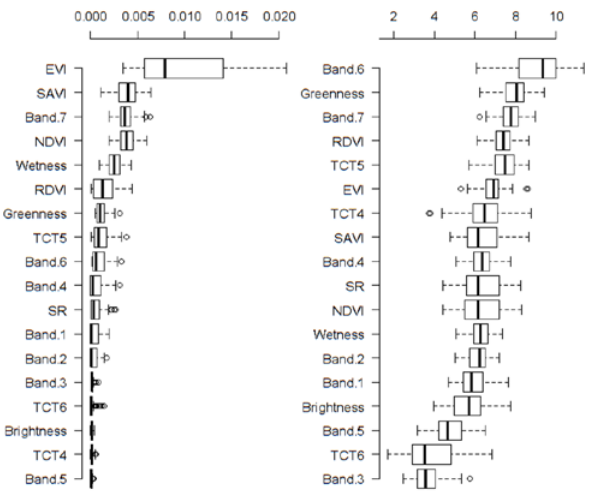
Figure 2: Variable importance of FPAR models cforest (left) rforest (right)